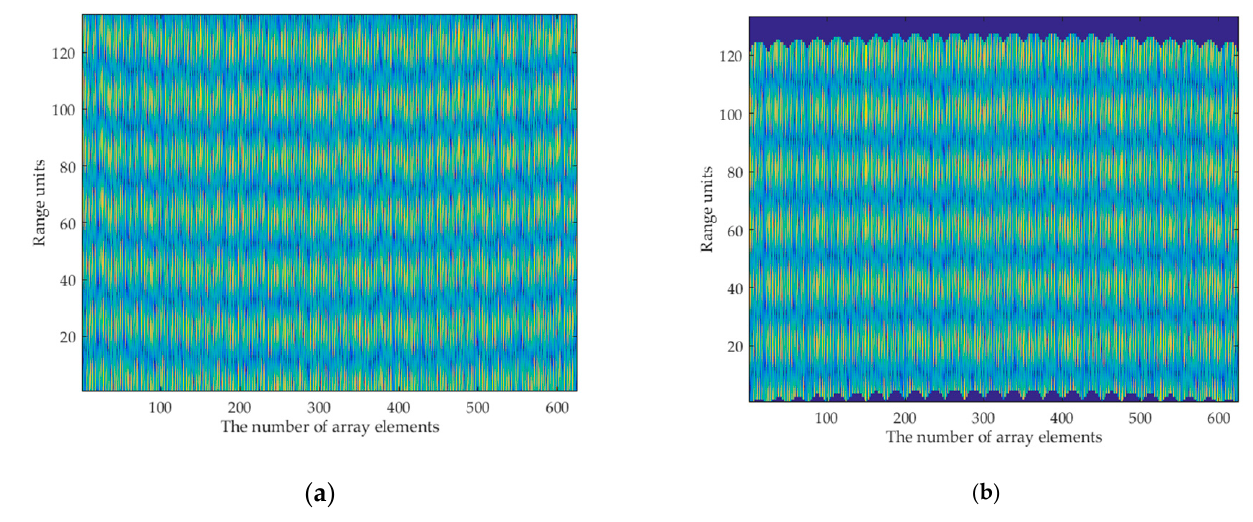
Figure 13. The images before and after interpolation are compared. ( a ) The echo signal s r before interpolation. ( b ) The echo signal s (cid:48) r after interpolation.